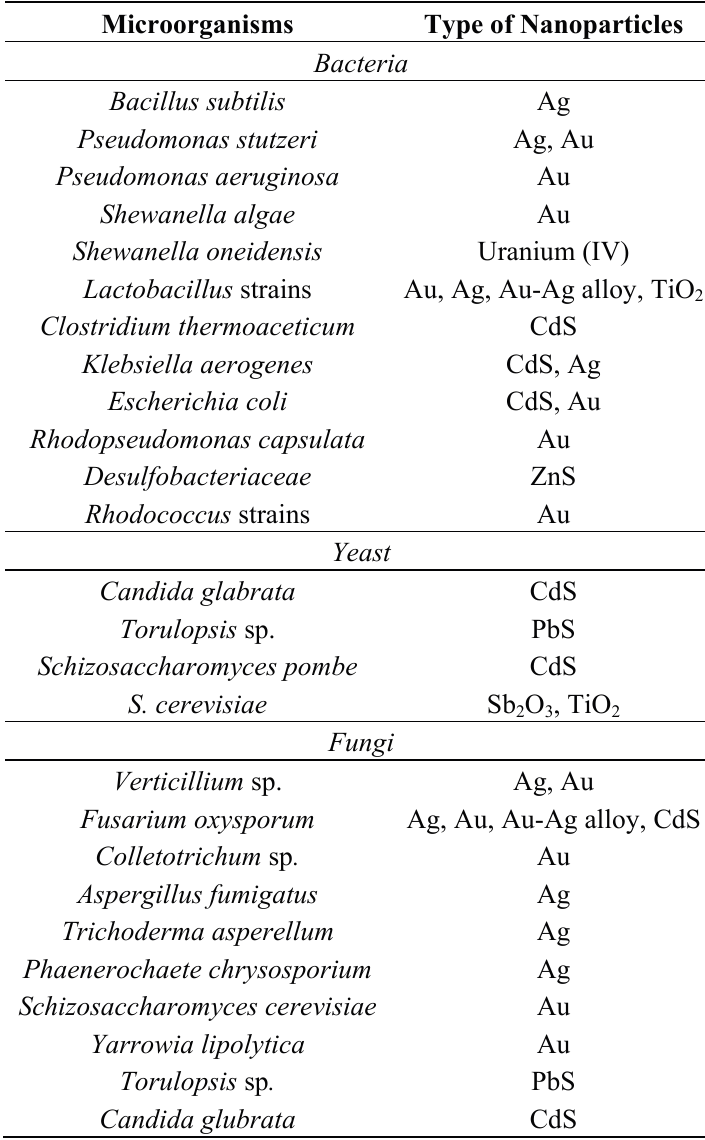
Table 1. List of microorganisms known to produced different nanoparticles modified from